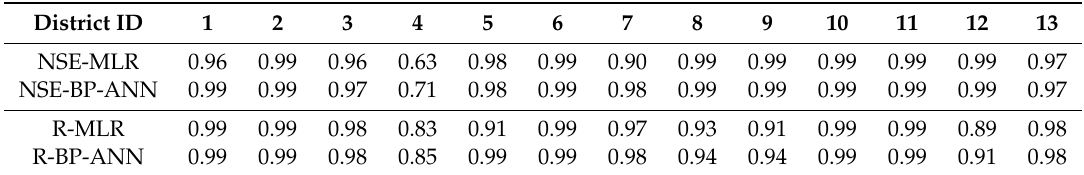
Table 2. Model efficiency evaluation of each